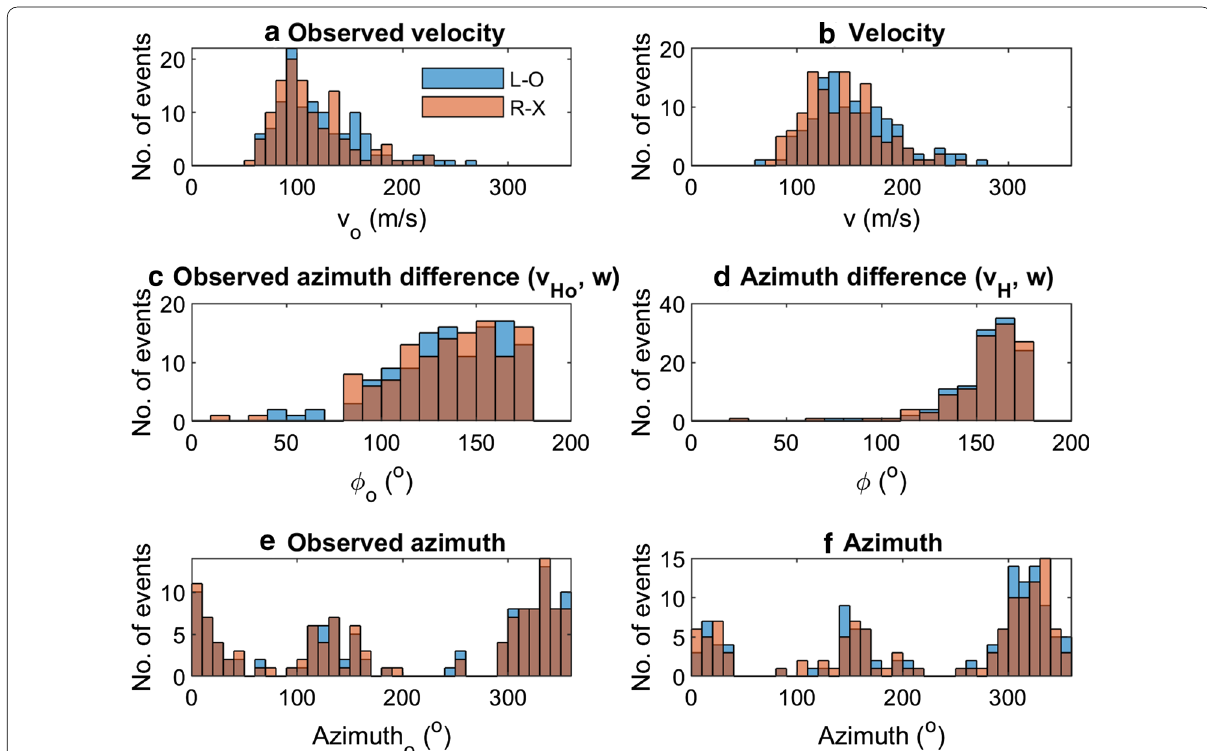
Fig. 7 Distribution of selected GW characteristics for the period September 2018–August 2019 (solar maximum) assuming L-O mode (blue) and R-X mode (orange) signals. a observed velocities v o , b wind rest frame velocities v , c observed azimuth difference φ o between v o ( v Ho ) and horizontal velocity w of neutral winds, d azimuth difference φ between v ( v H ) and horizontal velocity w of neutral winds, e observed azimuth, f